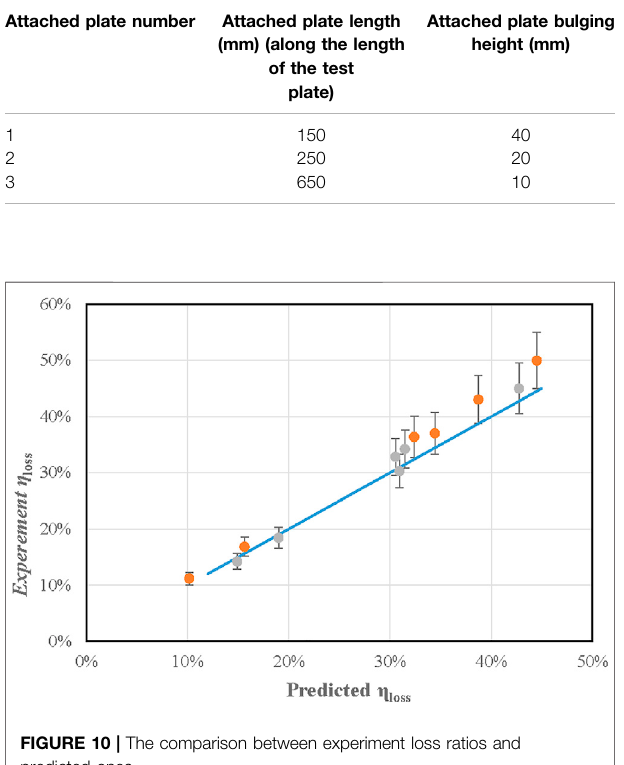
FIGURE 10 | The comparison between experiment loss ratios and predicted